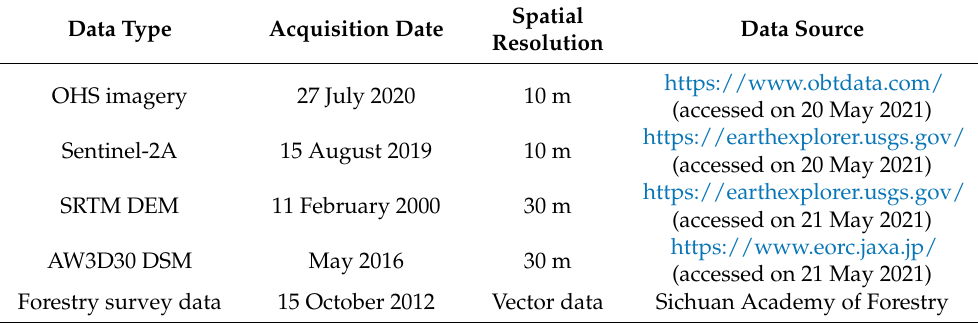
Table 1. OHS imagery and auxiliary data we used in this study.